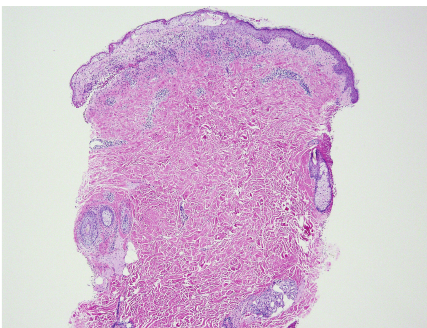
Figure 1: A low power (4x) skin H&E image reveals superficial band-like and perivascular inflammatory infiltrate with overlying epidermal necrosis and vesiculation.